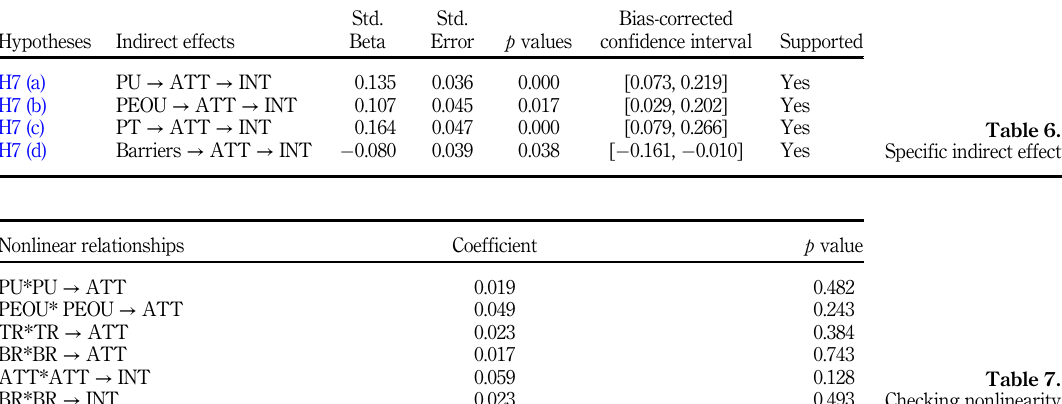
Table 7. Checking